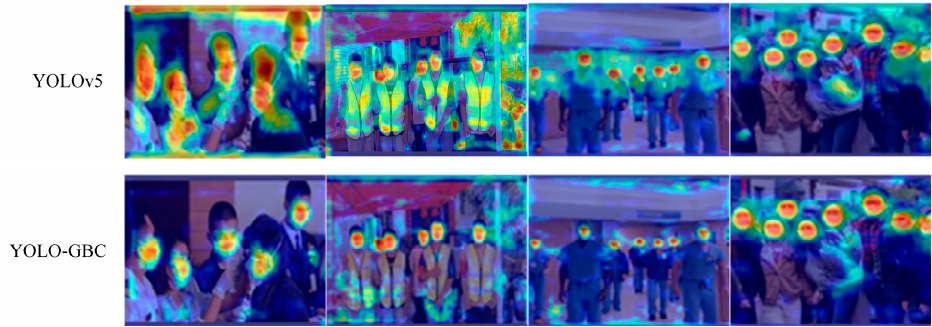
Figure 10. Comparison of the heat map of concern.